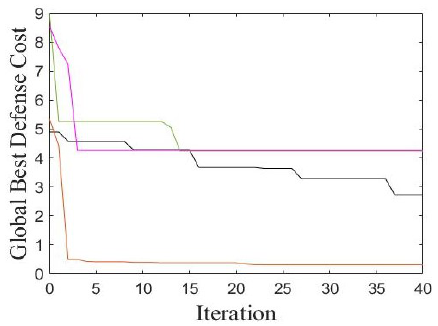
Figure 7. Convergence of defense cost against pincer formation, black: ζ 1 , orange: ζ 2 , green: ζ 3 , purple: ζ 4 .